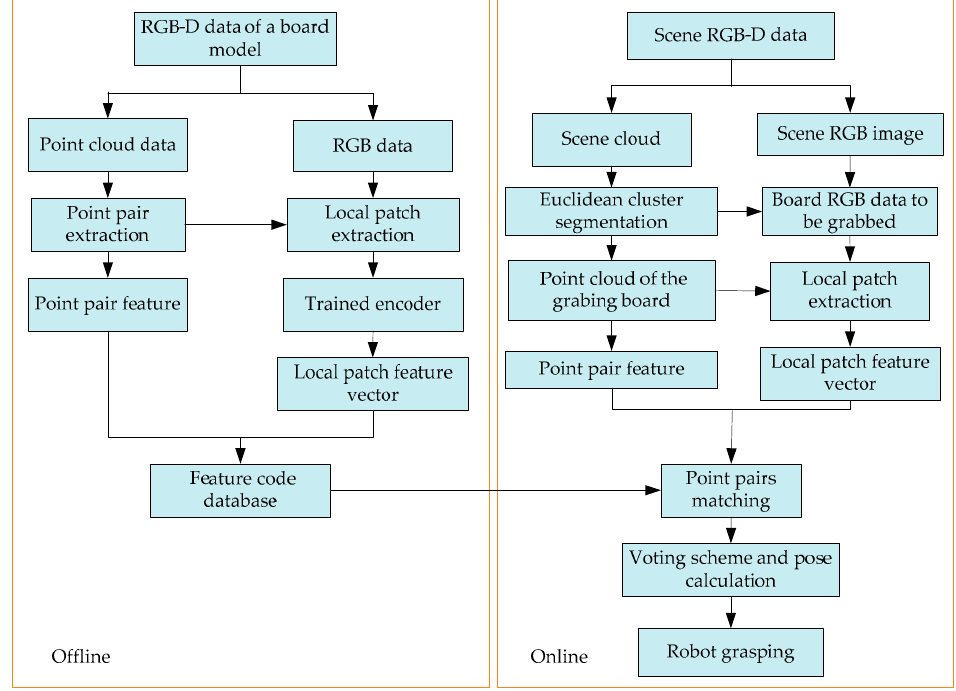
Figure 1. The overall algorithm flow of robot grasping.